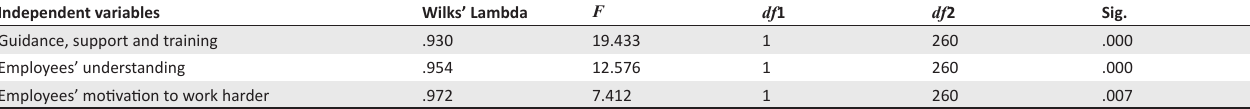
TABLE 8: Discriminant analysis for variables that predict the existing development plan. Independent